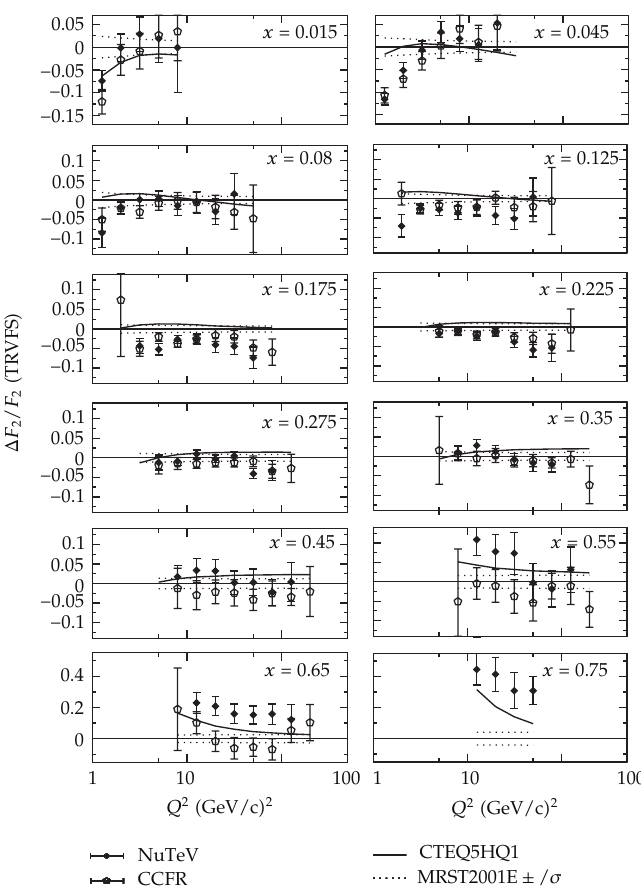
Figure 6: A comparison of the measurements of the F 2 structure function by NuTeV and CCFR and the predictions from the global PDF fits of the MRST and CTEQ collaboration (cid:6) 128 (cid:7) that does not use the NuTeV data points as input to their fit. The model predictions have already been corrected for target mass and, most significantly, nuclear e ff ects assuming these corrections are the same for charge-lepton and neutrino